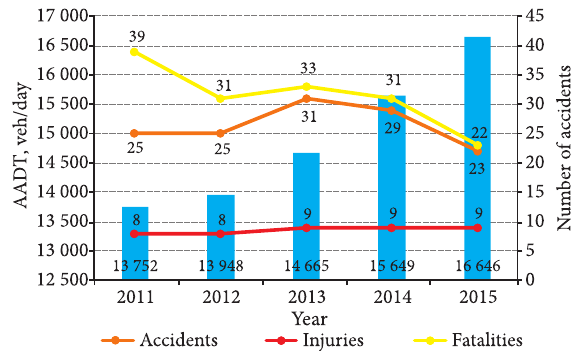
Fig. 2. Variation of traffic volume and accident on A5 road